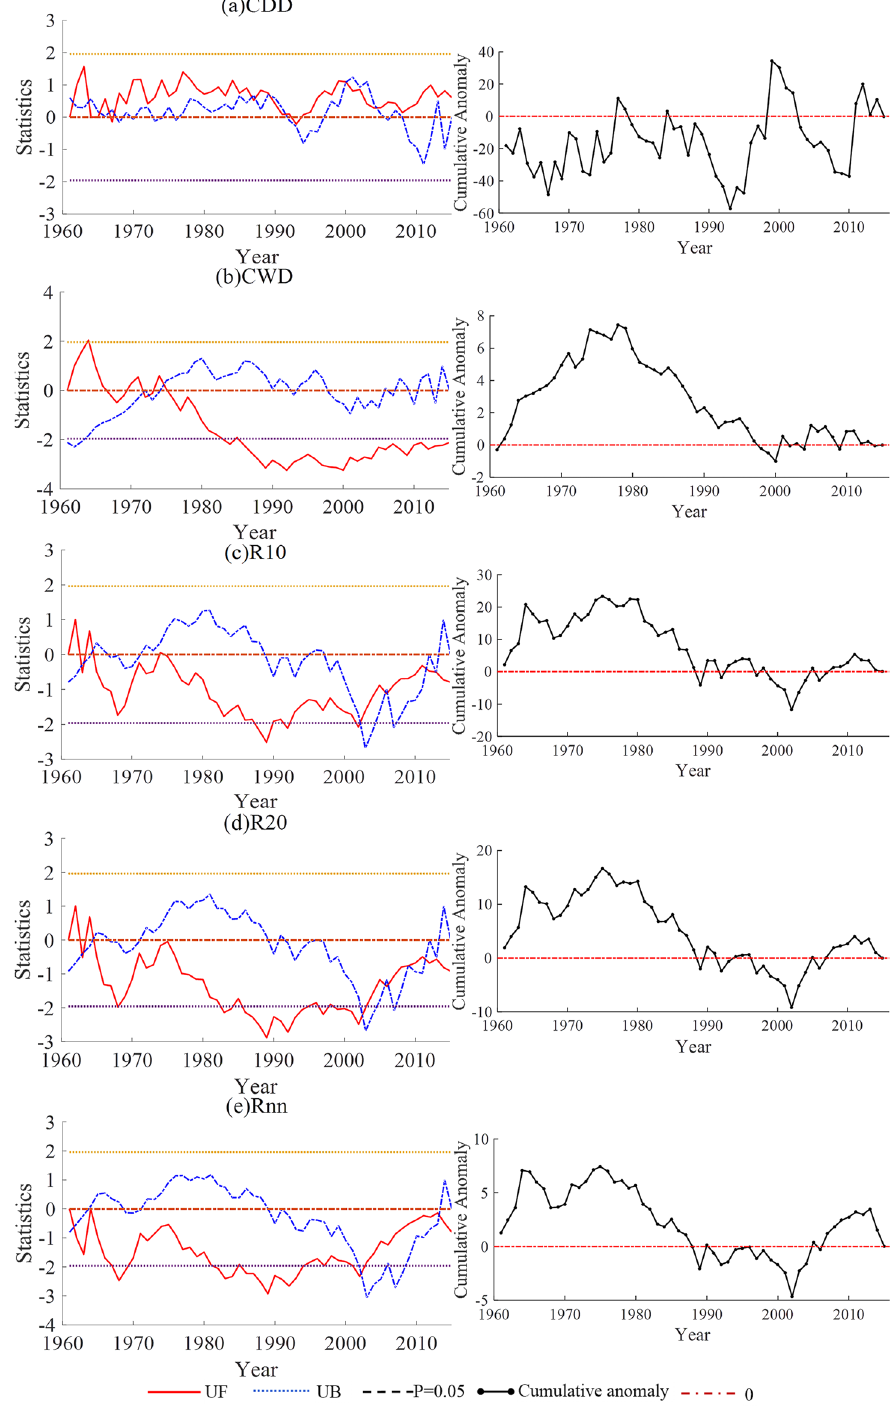
Figure 7. Mann–Kendall test and cumulative anomaly of indices of the number of precipitation days in Shandong from 1961 to